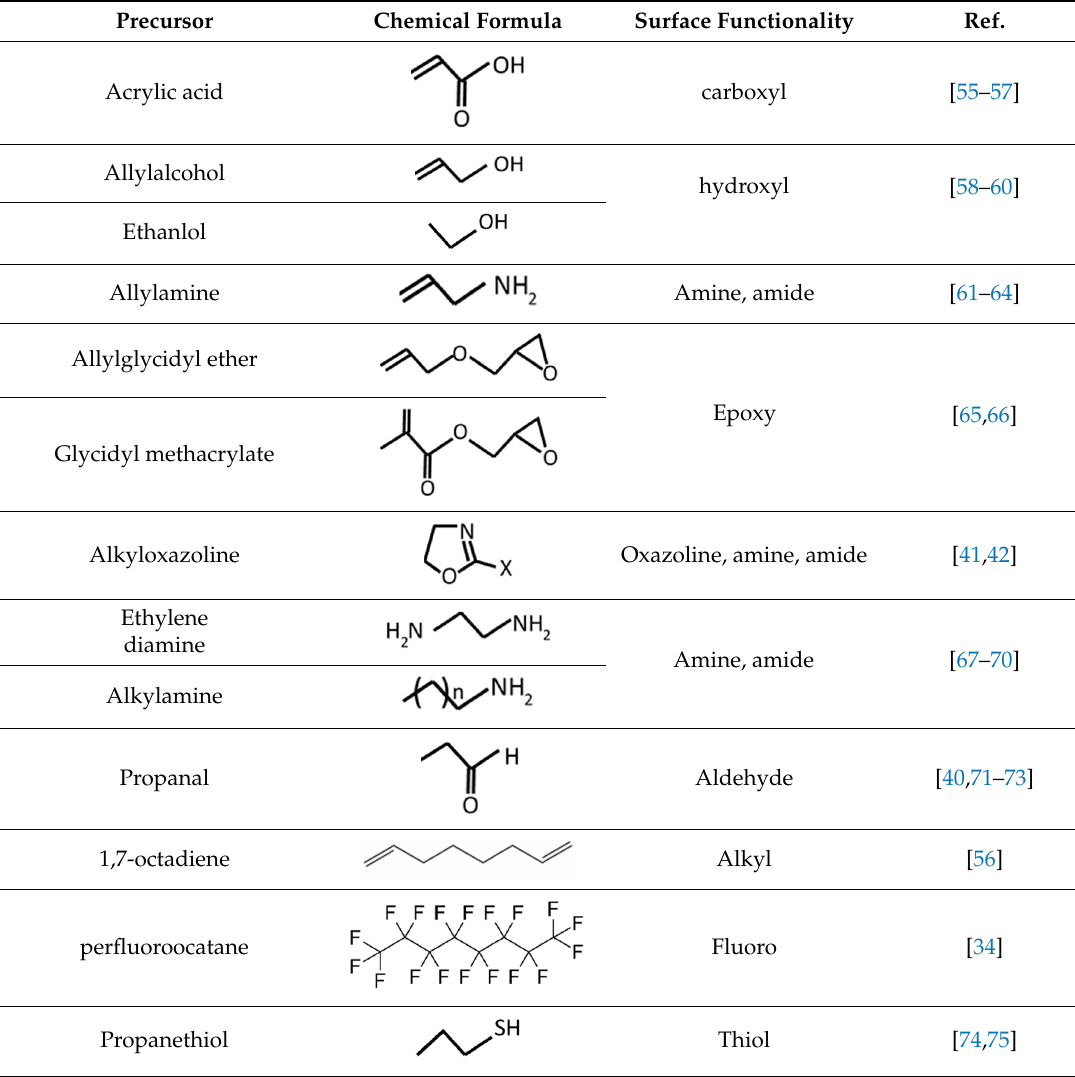
Table 1. Examples of common organic precursors used to prepare plasma-deposited film with different surface chemistry.